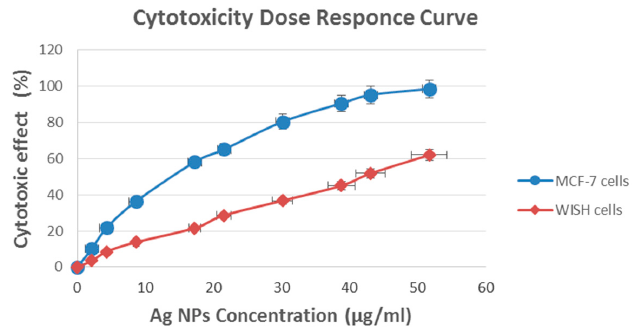
Figure 6. Cytotoxic effect of AgNPs synthesized by Fusarium oxysporum against MCF-7 and normal WISH cell lines